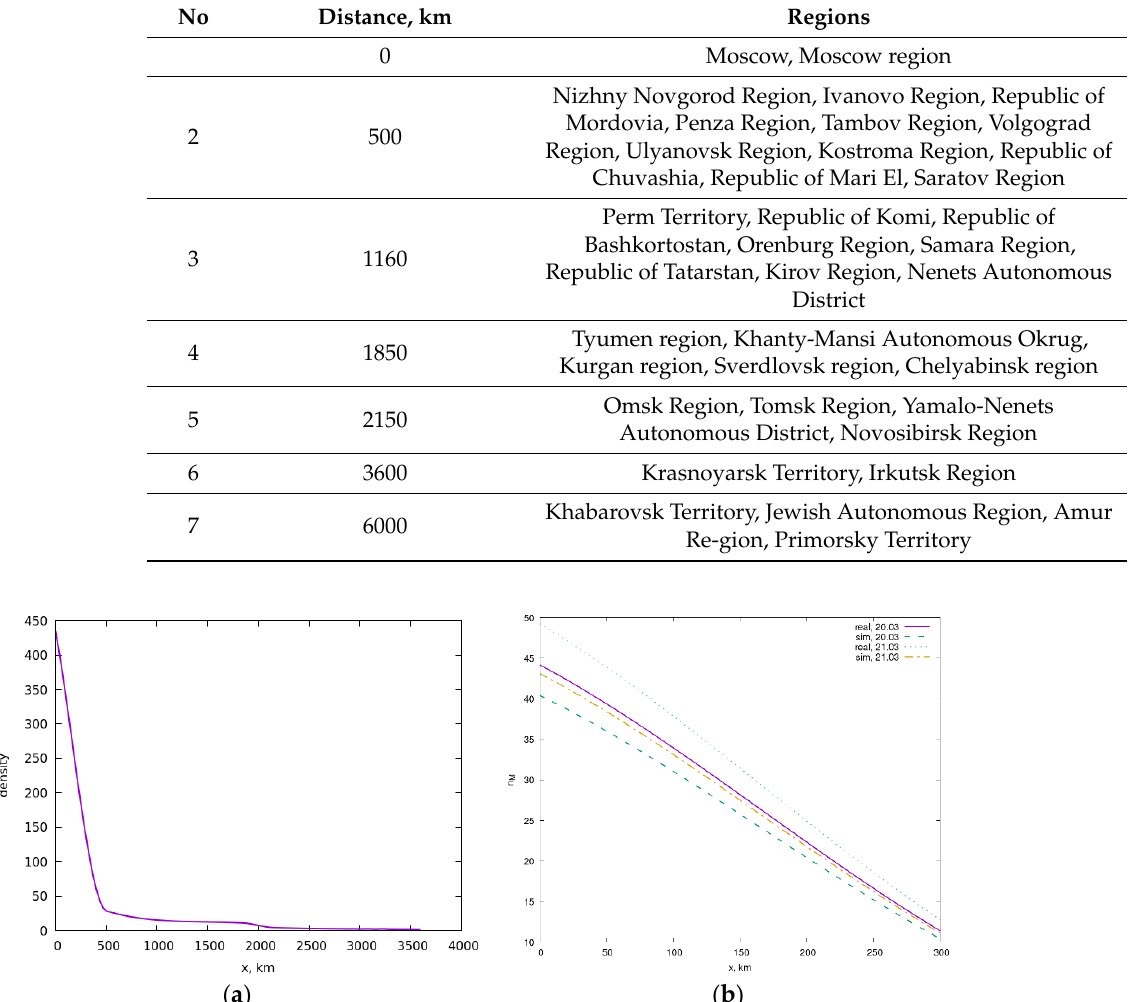
Figure 9. ( a ) Linear density of population in Russia. ( b ) A closer look at real and theoretical data for the value 𝑛 𝑀 for two subsequent days in Russia.